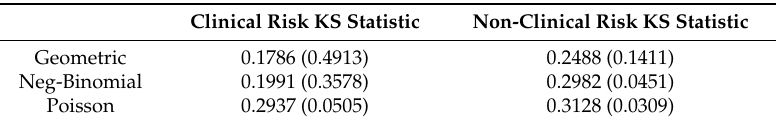
Table 5. Kolmogorov-Smirnov test of frequency distribution.